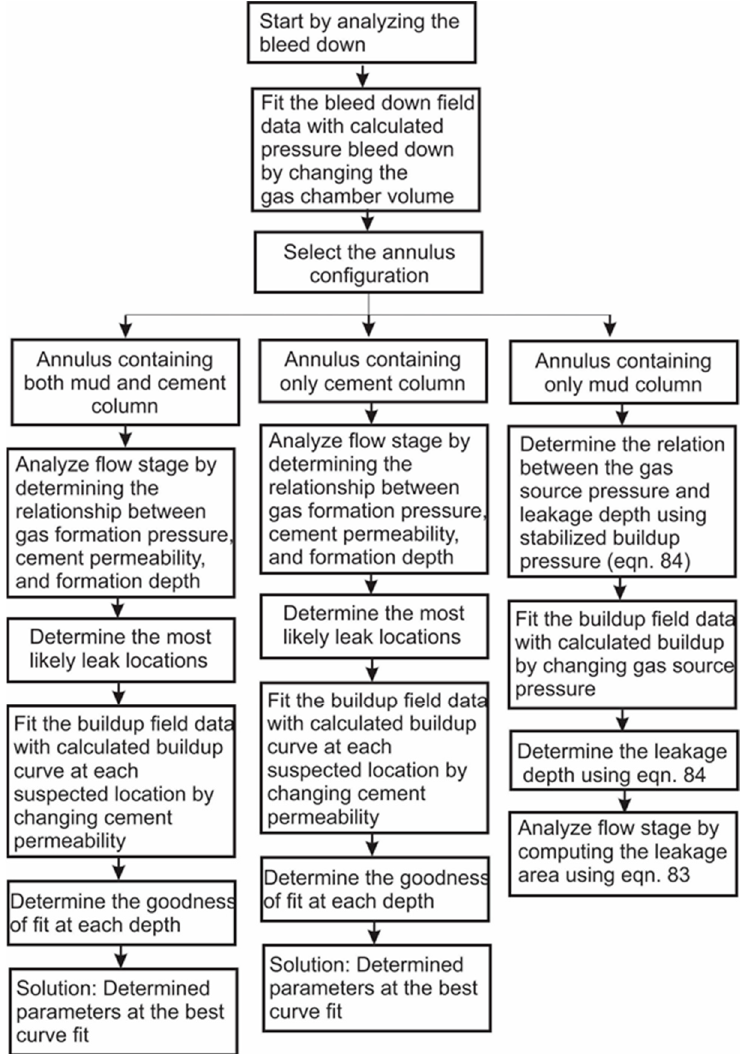
Figure 6. Flow chart describing the analysis method for different annulus configurations.